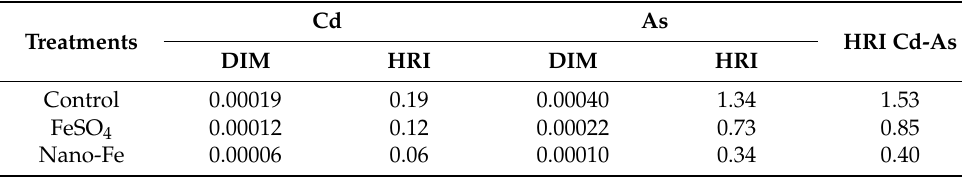
Table 5. Risk assessment of Cd and As intake via rice grain treated with exogenous Fe.